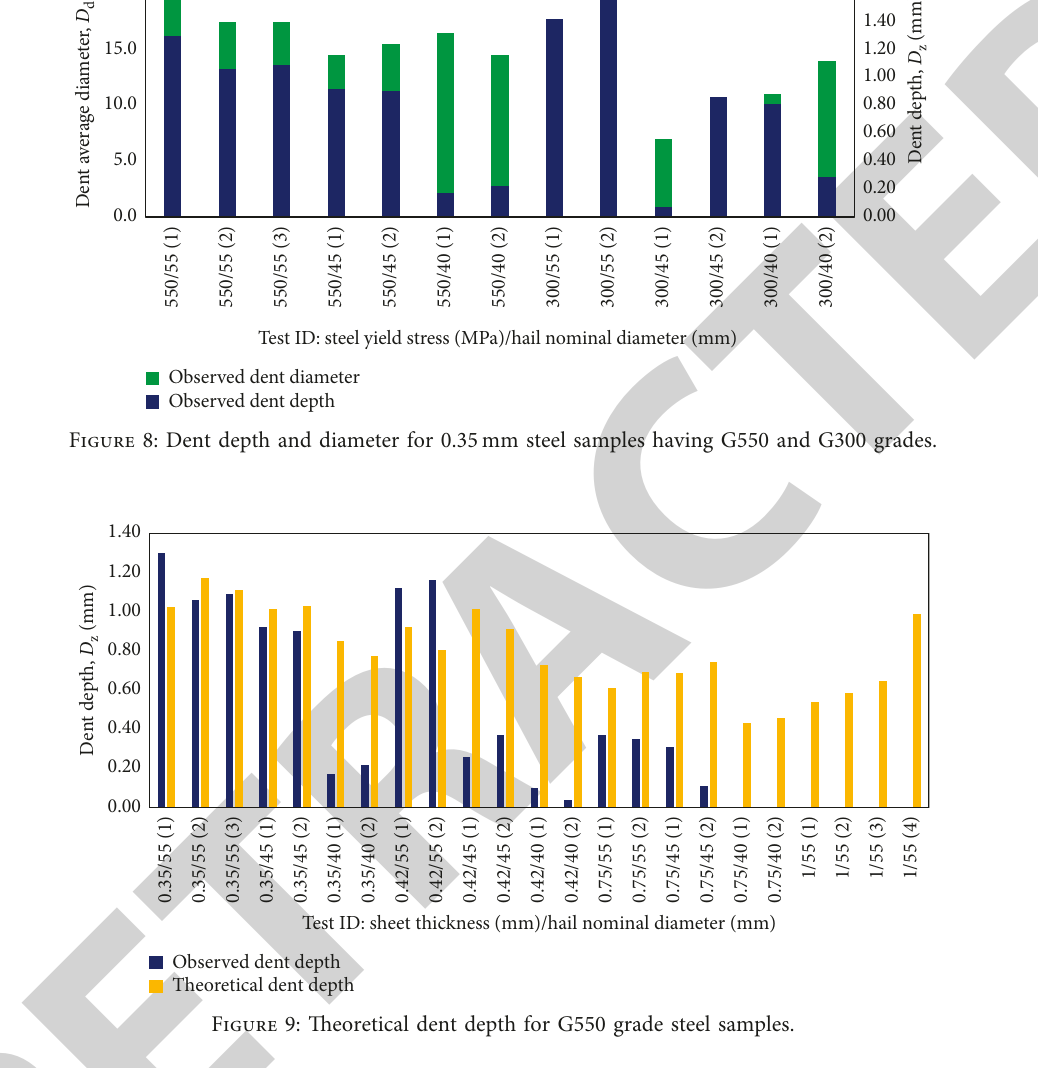
Figure 9: Theoretical dent depth for G550 grade steel